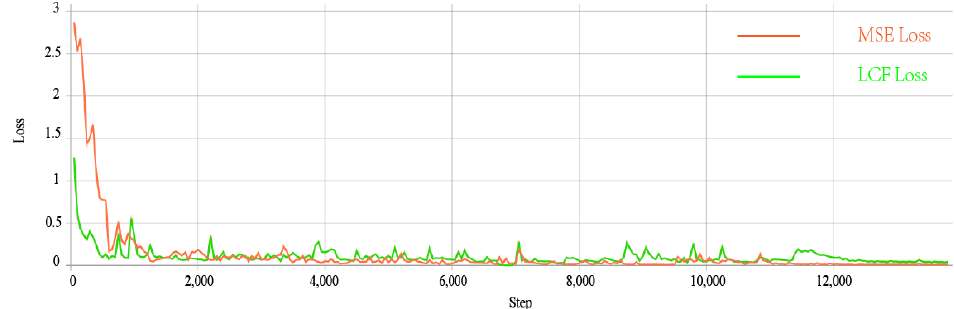
Figure 7. Comparison of images on different loss functions. The panels of ( a – f ) are images derived from the TNO dataset and the Roadscene dataset. From left to right, each row is as follows: Visible image. Infrared image. The fusion result constrained by the MSE. Our fusion result.